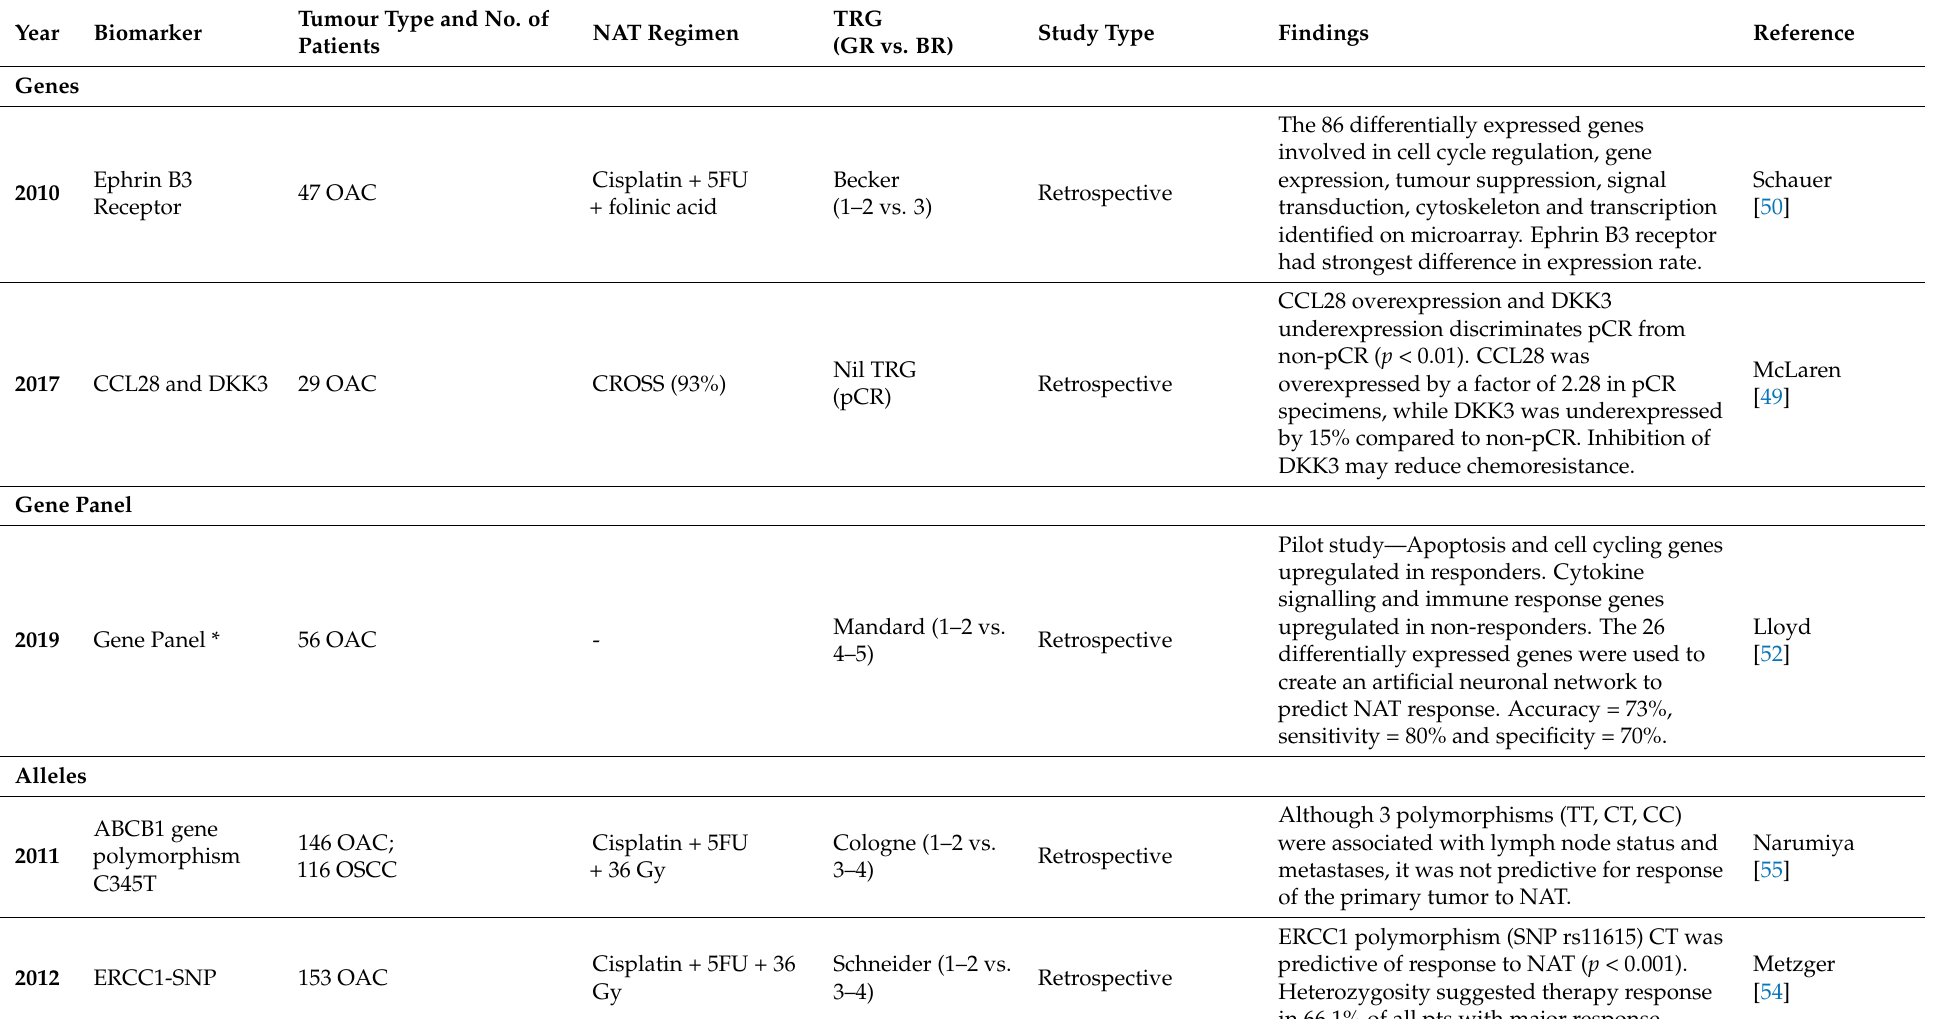
Table A3. Genetic